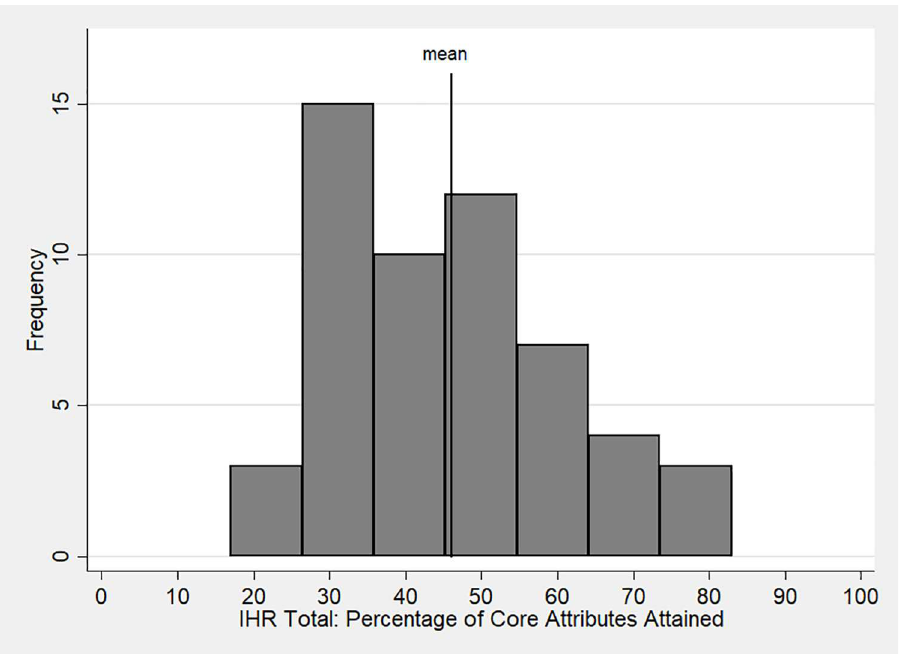
Fig 1. Distribution of UN International Health Regulations core capacities in